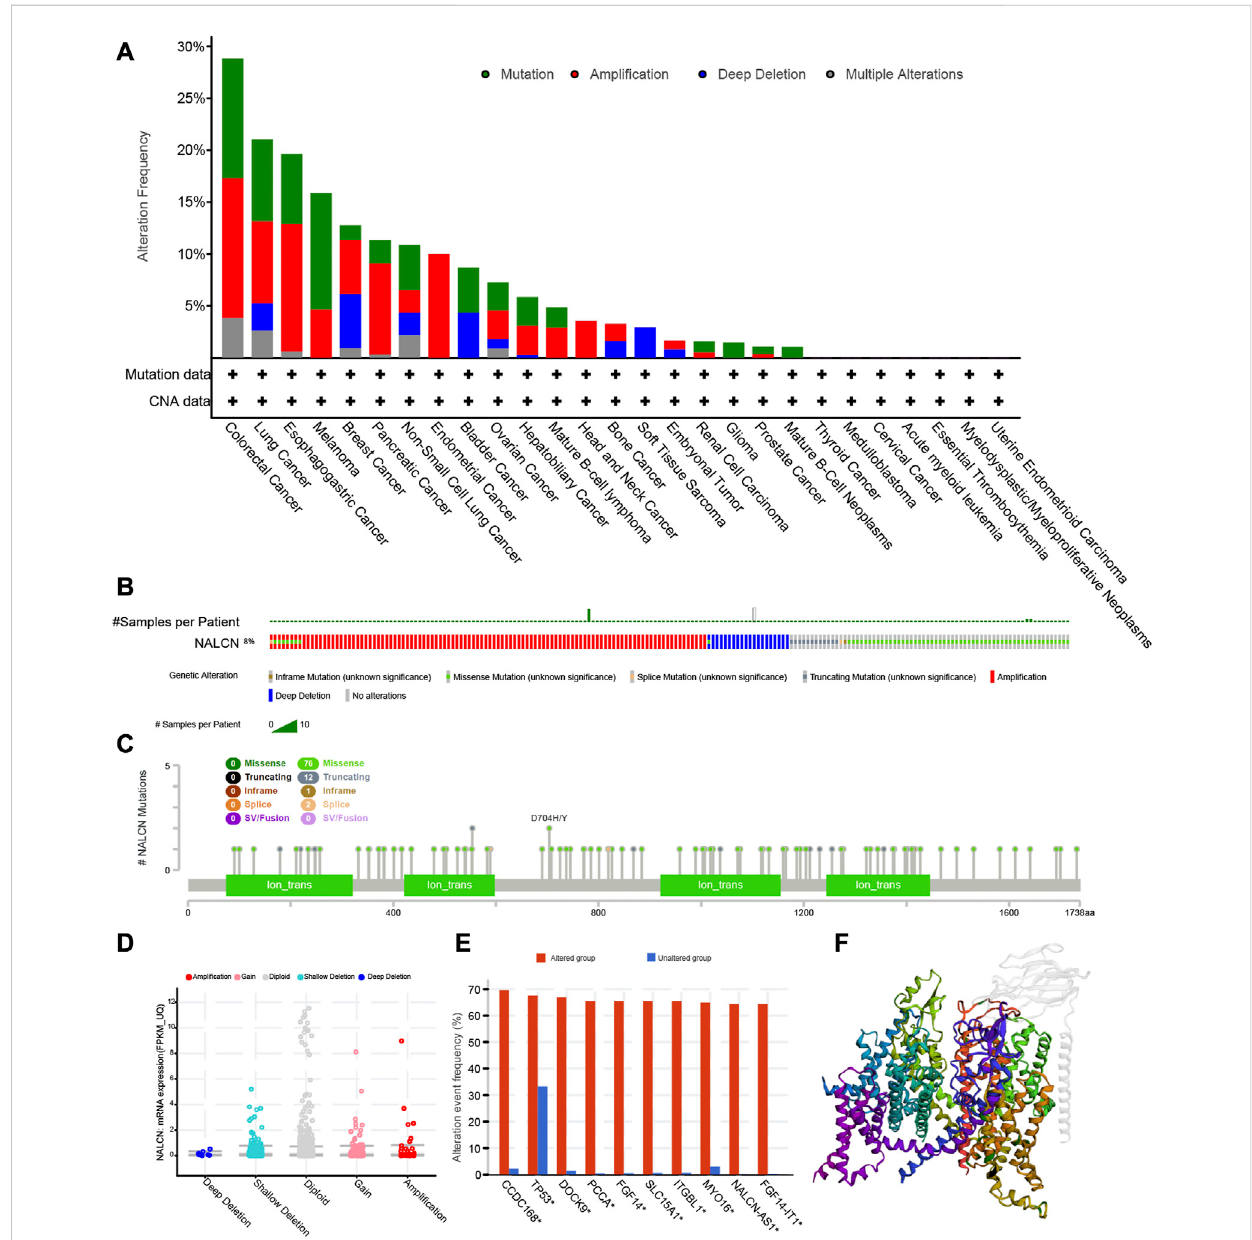
FIGURE 10 The genetic alterations of NALCN in different tumors of TCGA. (A) Alterations summary of NALCN for the TCGA tumors. (B) Summary of NALCN structuralvariant,mutations,andcopy-numberalterations. (C) Themutationtypes,number,andsitesoftheNALCNgeneticalterations. (D) Thealteration typesofNALCNinpan-cancer. (E) ThealterationfrequencyofrelatedgenesinNALCNalteredgroupandunalteredgroup. (F) The3DstructureofNALCN